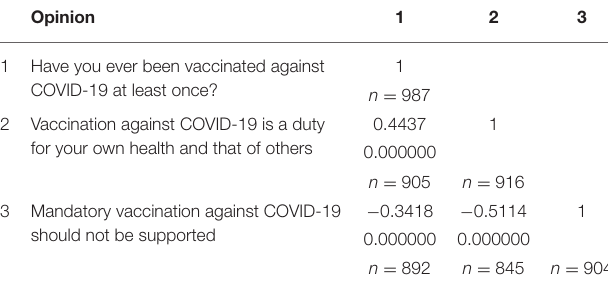
TABLE 2 | Correlations between people’s views on vaccination obligation